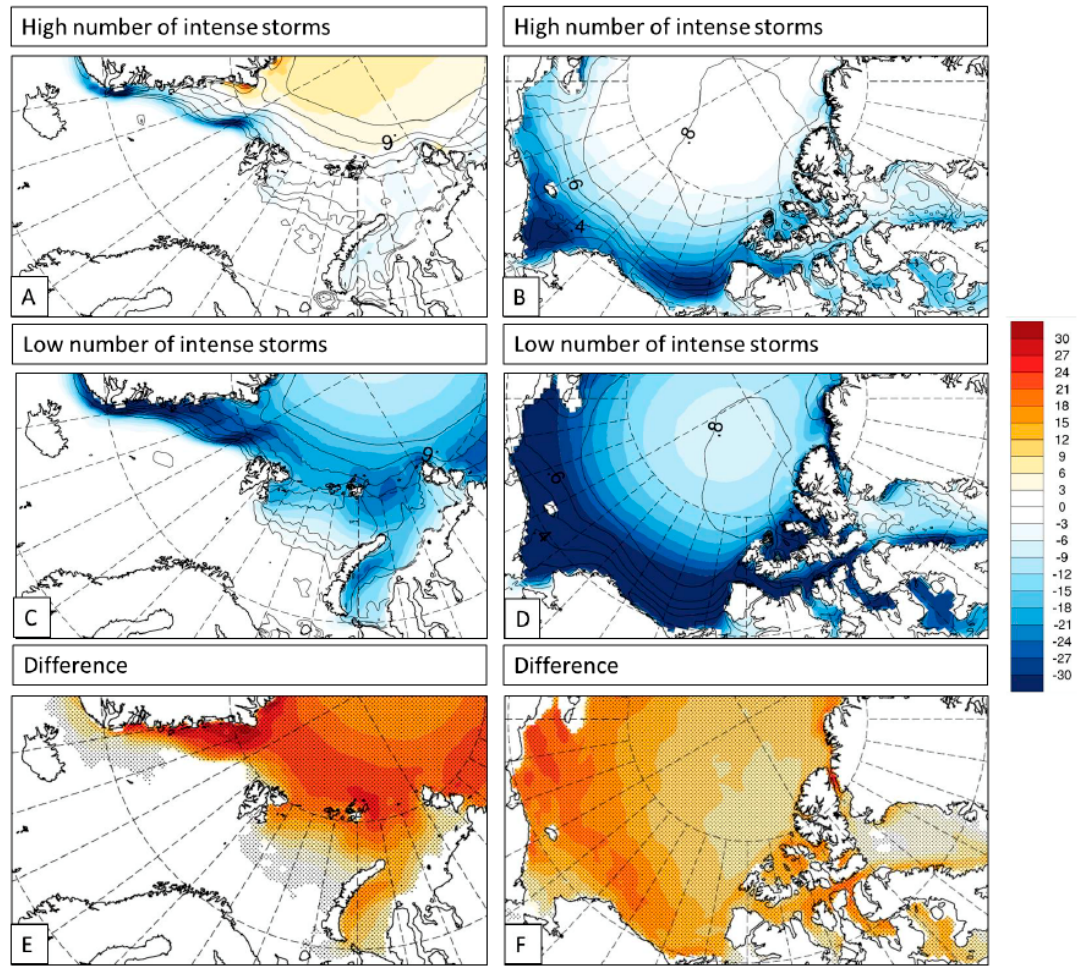
Figure 7. The same as Figure 4, but for the net sea-ice heat fluxes (unit: W / m 2 ). Positive (negative) fluxes point upward (downward). ( a , c , e ) show the composite analysis results in the Atlantic Arctic Ocean and ( b , d , f ) show those in the Pacific Arctic Ocean region specifically.